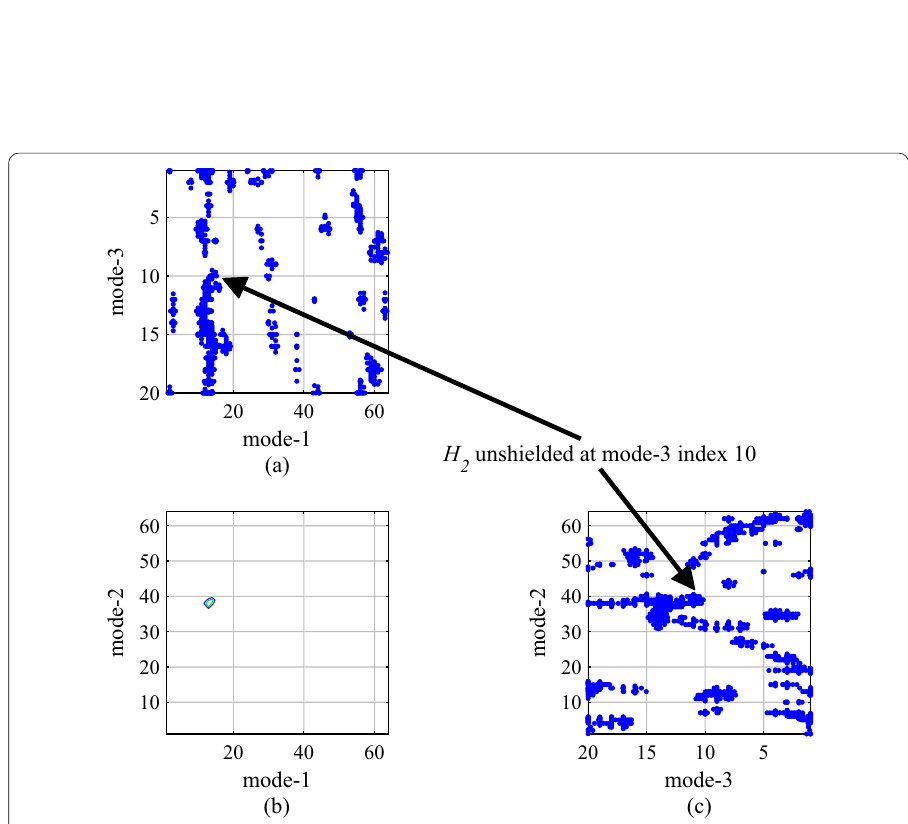
Fig. 7 Phase congruency in data tensor D with unshielding of H 2 at frame 10 (mode-3 index 10). a , c Scatter plots along mode-3. b 3-level contour